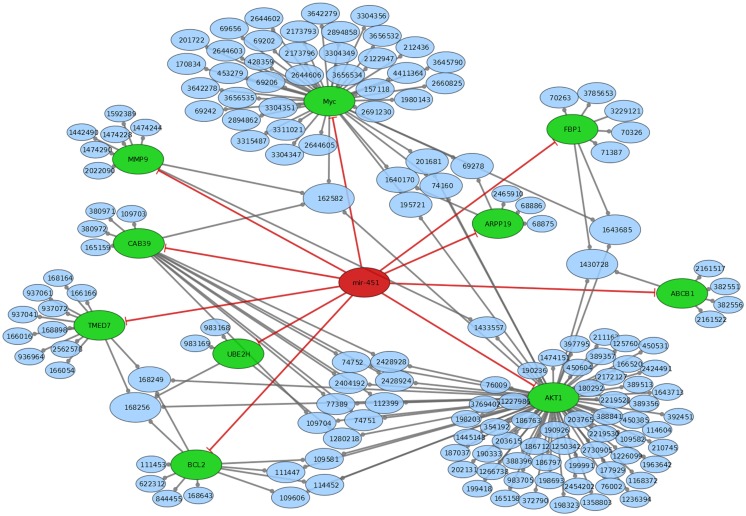
Mir-451 comes from a link RNA (not shown in graph). Mir-451 has 10 known targets (green). These targets are part of a number of reactome pathways (blue). The number in the blue nodes can be used to access the associated reactome pathway, and Table S3 in Supplementary Material provides further information for clarity. Size of blue nodes reflects the number of mir-885 targets it contains. Edges ending in circles (gray) indicate a part of relationship (e.g., FBP1 is a part of the “glycogen storage diseases” pathway, which has the reactome accession number 3229121). Edges ending in straight lines (red) indicate inhibition of the target (e.g., mir-451 inhibits AKT1).